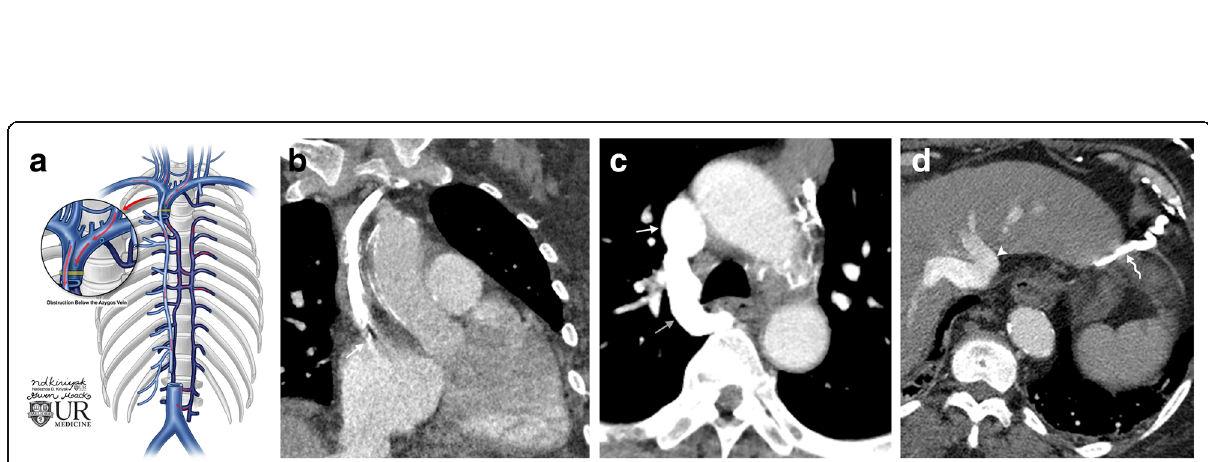
Fig. 11 Blockage of the SVC below the azygos vein. a Schematic image of a SVC obstruction at the level of the azygos vein and pathway for collateral flow. b Coronal CT image shows occlusion of the SVC below the level of the azygos vein (white arrow). c Axial CT image demonstrates retrograde contrast flow through the azygos vein (gray arrow) from the upper SVC (white arrow). d Axial CT image showing diaphragmatic collaterals (curved arrow) draining to the IVC (arrowhead) bypassing the inferior SVC blockage below the level of the azygos vein